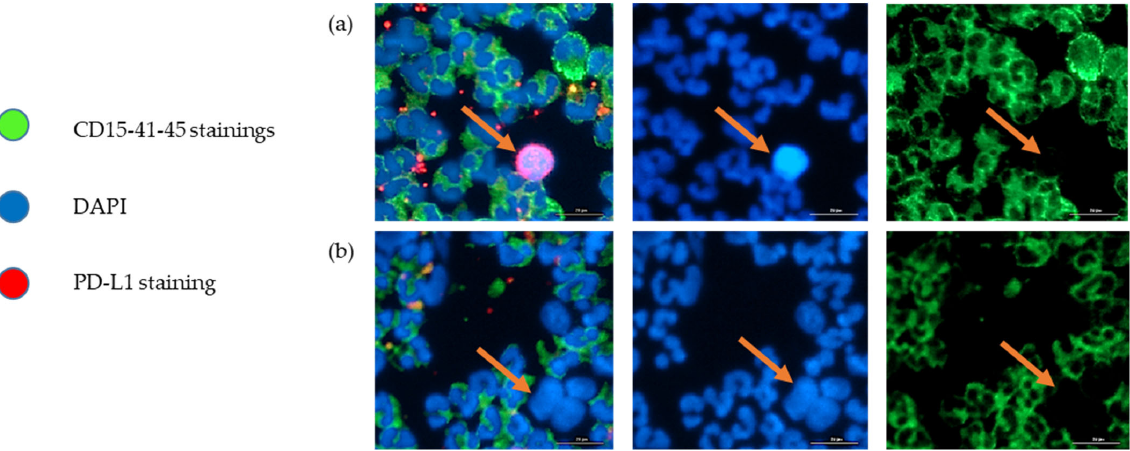
Figure 3. Representative images of immune cells (CD15+, CD41+, CD45+, DAPI+), and CTCs (CD15 ‐ , CD41 ‐ , CD45 ‐ , DAPI+, PD ‐ L1+/ − ) of the sample from patient 28, after ClearCell FX1 enrichment. The arrows indicate a CTC. ( a ) PD ‐ L1 ‐ positive CTC, ( b ) PD ‐ L1 ‐ negative CTC. Scale bar = 20 μ m.